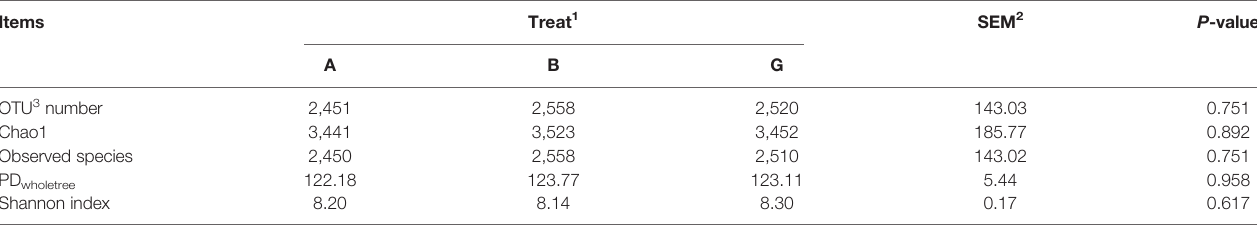
TABLE 5 | Rumen microbial richness and diversity affected by dietary non-protein nitrogen sources.